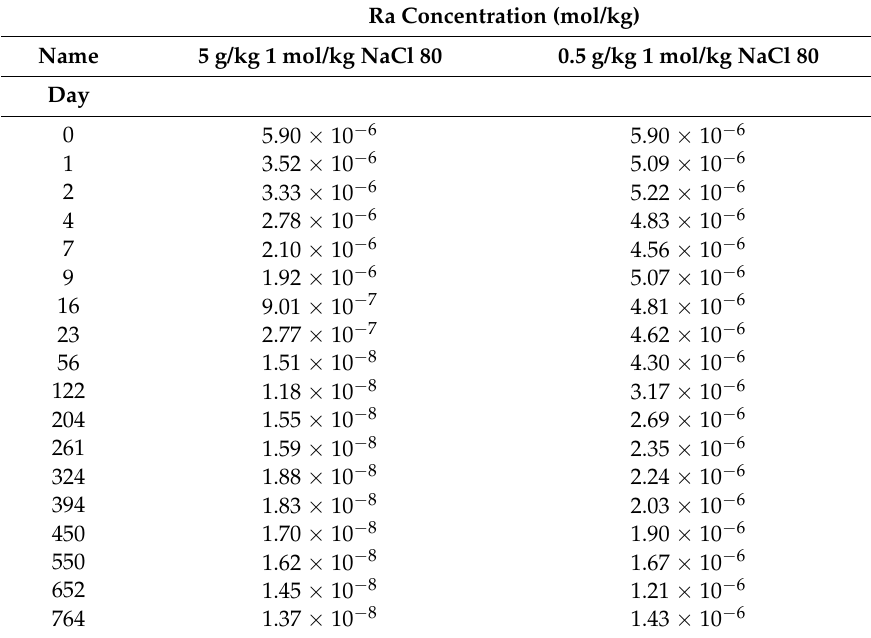
Table A2. Ra concentrations of experiments with 1.0 mol/kg NaCl at 80 ◦ C.